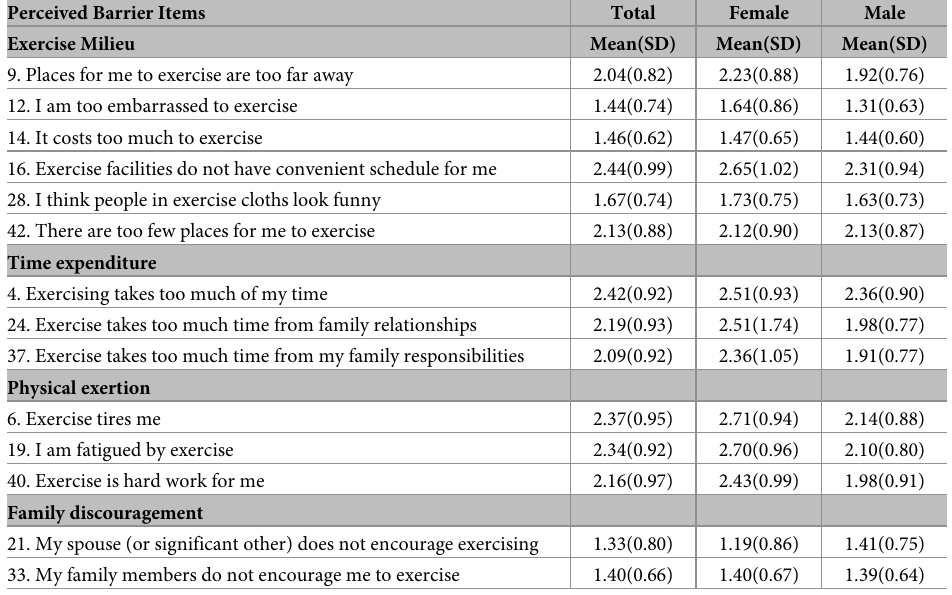
Table 6. Perceived physical activity barrier sub-scales among urban female and male diabetic patients in Nepal (n = 270). Perceived Barrier